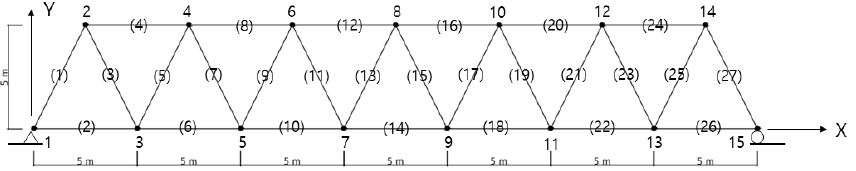
Figure 1. A plane truss. The number without parentheses indicates the node and the number with parentheses the element.